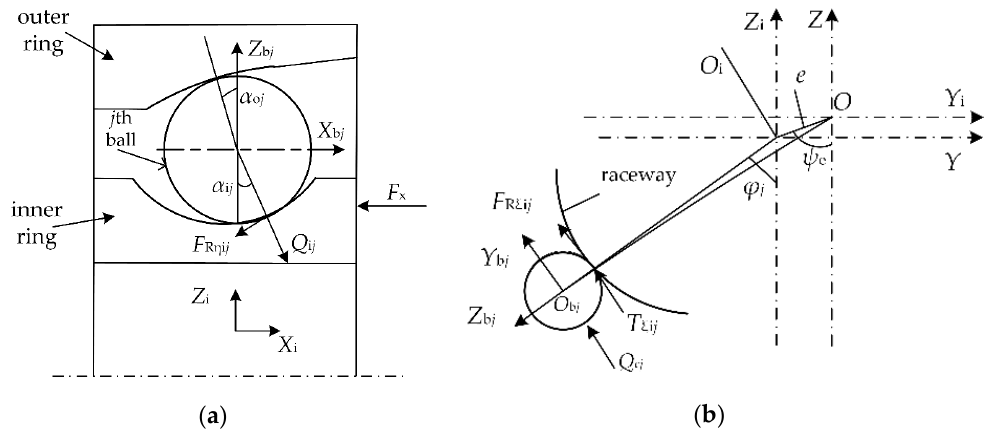
Figure 1. The force model of the inner ring in the plane XOZ ( a ) and in the plane YOZ ( b ).